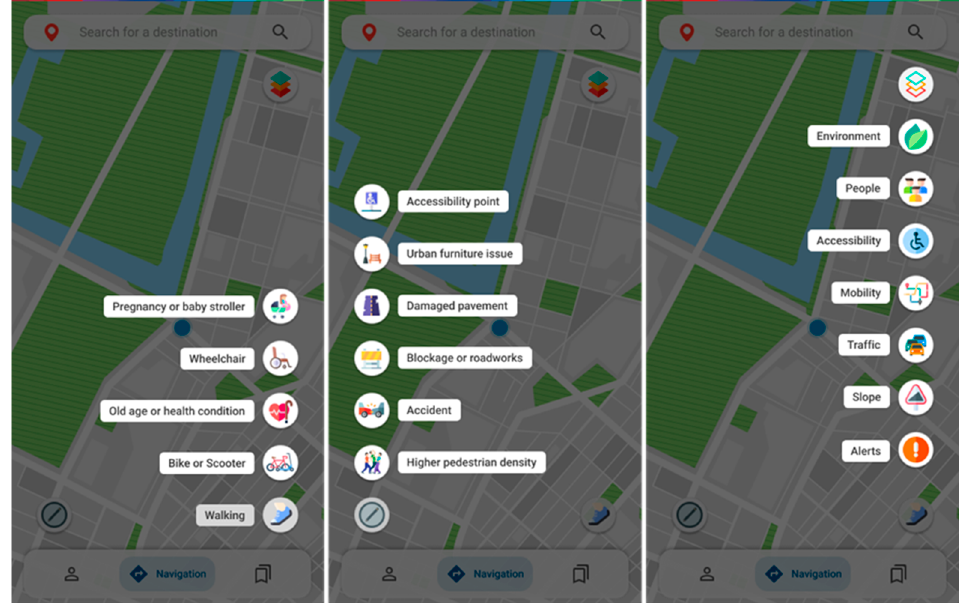
Figure 5. Screens for choosing the mode of transport, reporting issues or events, and consulting information.